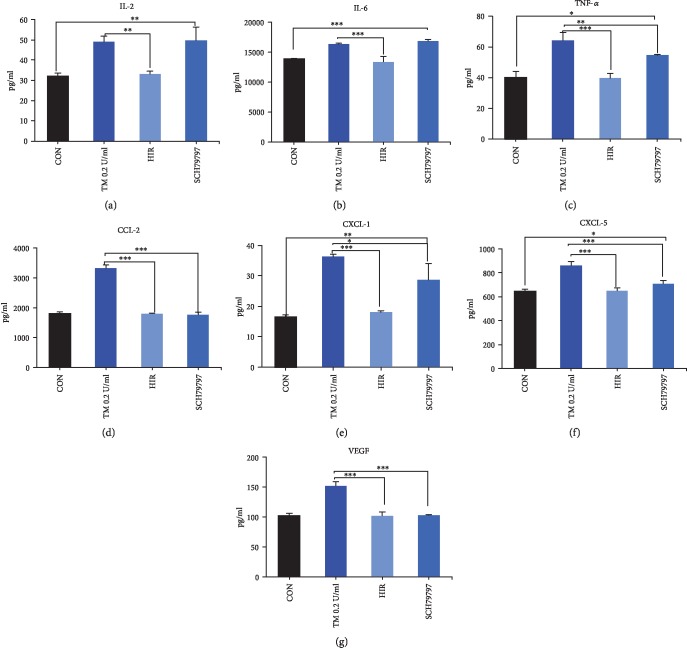
Effect of thrombin inhibitor and PAR1 inhibitor on thrombin-induced releasing of mediators of P815 cell. Thrombin inhibitor (hirudin) diminished secretion of mediators from P815 cells. Compared with TM 0.2 U/ml group, PAR1 inhibitor (SCH79797) decreased secretions of TNF-α (c), CCL-2 (d), CXCL-5 (e), CXCL-1 (f), and VEGF (g), but not of IL-2 (a) and IL-6 (b). Compared with the control group, expression of IL-2 (a), IL-6 (b), TNF-α (c), CXCL-1 (e), and CXCL-5 (f) remained increased in the SCH79797 groups. ANOVA was performed. Multiple comparisons were applied to compare the difference between inhibited groups and the thrombin group or control group. ∗ means that the difference was statistically significant between groups; ∗P < 0.05, ∗∗P < 0.01, and ∗∗∗P < 0.001. Difference between the control group and the thrombin group is shown in Figure 3. Difference between the control group and the hirudin group was not statistically different. CON: control group; TM: thrombin.